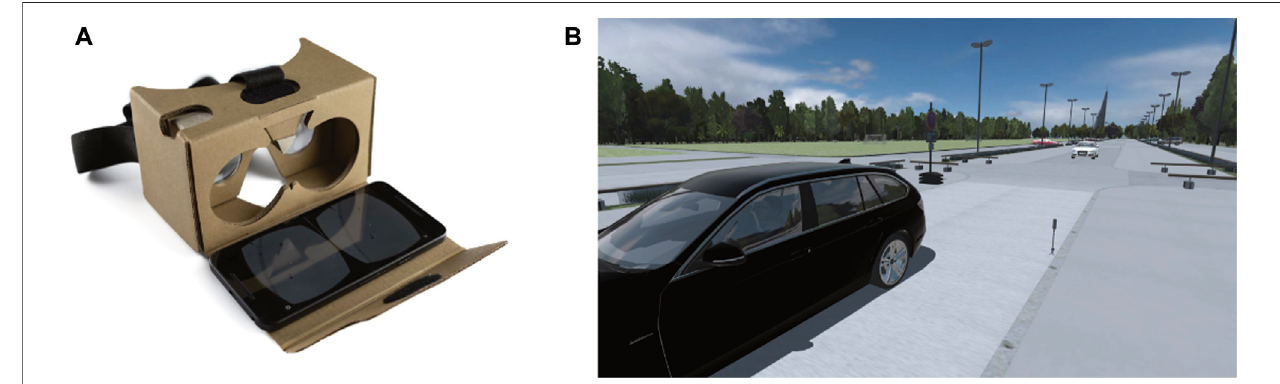
FIGURE 2 | (A) Google Cardboard Version 2.0 Viewer with a Google Nexis 5 Smartphone. (B) View from the subject ’ s perspective during the experiment. Shown here is a 3-second gap at 30 km / h